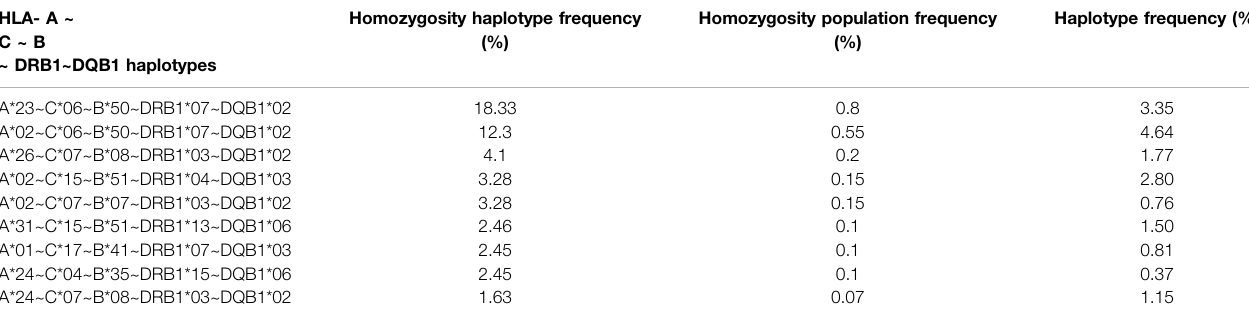
TABLE 7 | Frequency of HLA- A ~ C ~ B ~ DRB1~DQB1 haplotype homozygosity and haplotype frequency in Saudi population. HLA- A ~ C ~ B ~ DRB1~DQB1